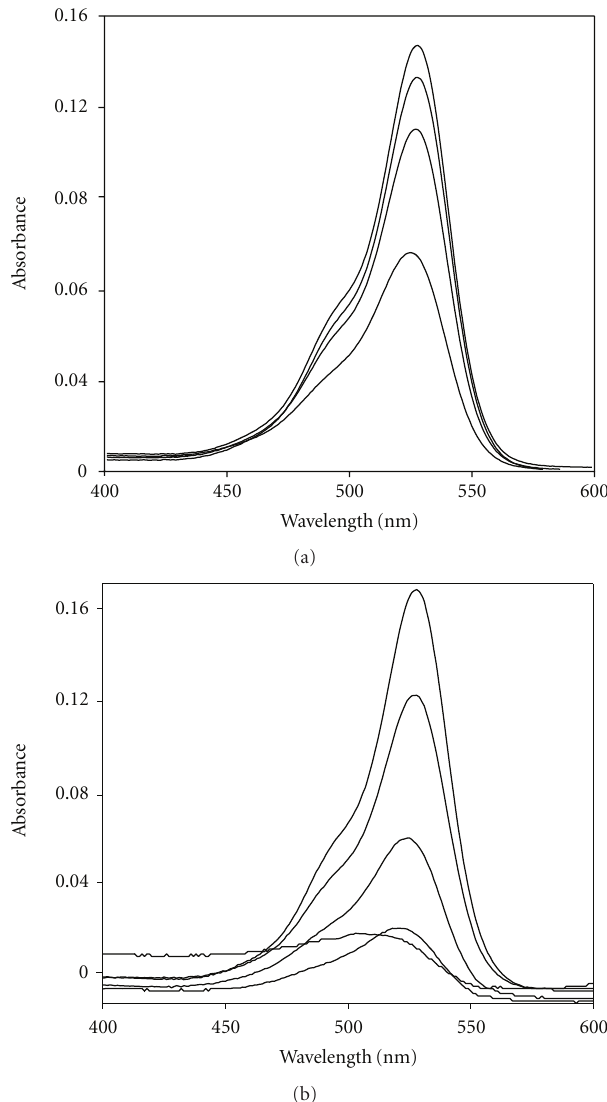
Figure 3: Visible spectra of rhodamine 6G during photocatalytic degradation. (a) Without bias (open-circuit conditions). Exposure times are 0, 6, 24, and 70hrs. (b) Under positive bias of 200mV. Exposure times are 0, 4, 25, 50, and